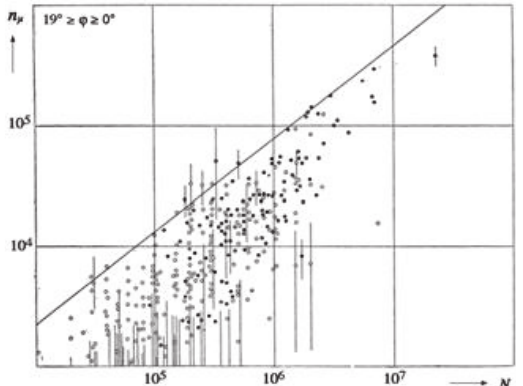
Fig. 2. Reconstructed muon number N μ , vs. shower size N for vertical showers